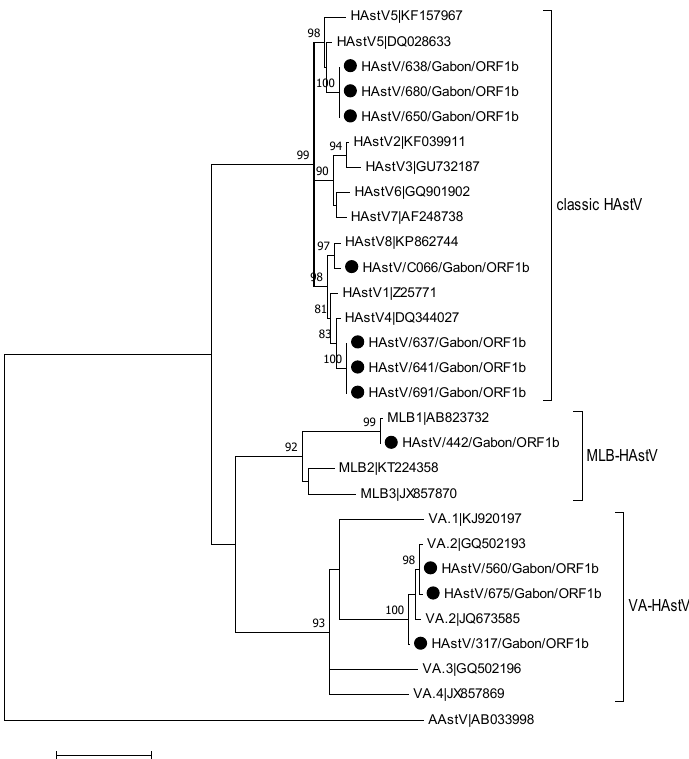
Figure 4. Phylogenetic tree of a 419 bp alignment of ORF1b region of astrovirus strains from Gabon and HAstV reference strains (accession nos. are indicated). Samples from symptomatic patients are marked with a dot and samples from asymptomatic patients with a rhombus. The tree was constructed using the maximum likelihood method with the bootstrap test (1000 replicates) and Tamura 3-parameter method available in MEGA7. The bar indicates the nucleotide substitution per site.